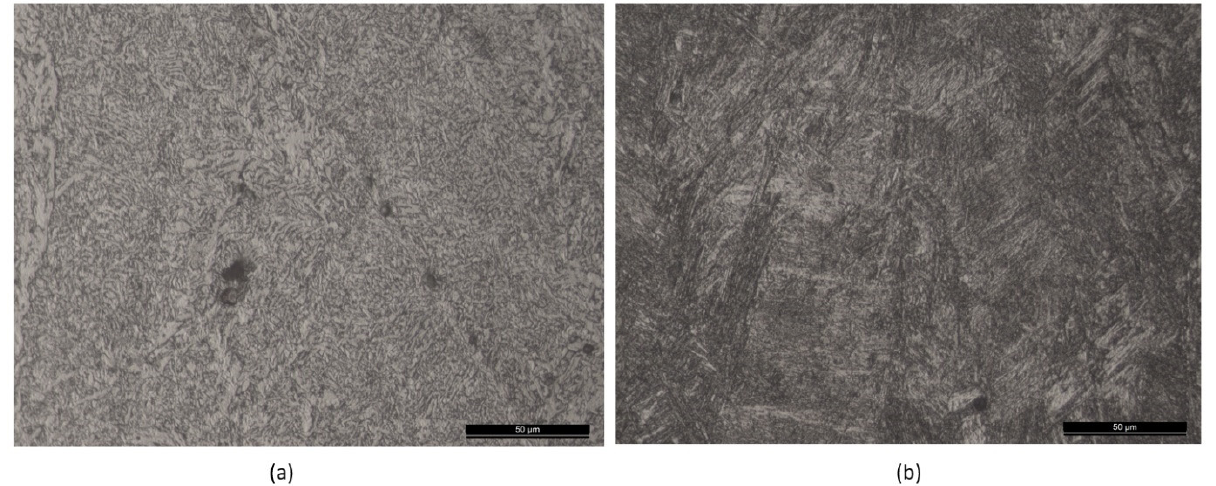
Figure 6. Micrographs of high ( a ) and low ( b ) heat input samples fabricated using CMT.